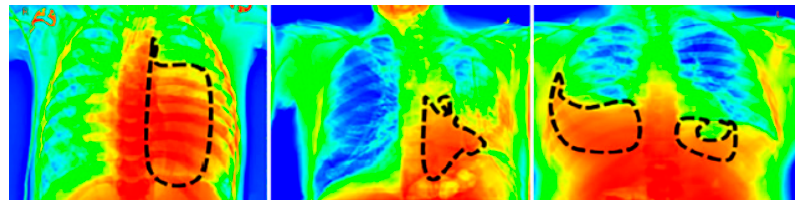
Figure 8. Grad-Cam heat map of the proposed model’s output.